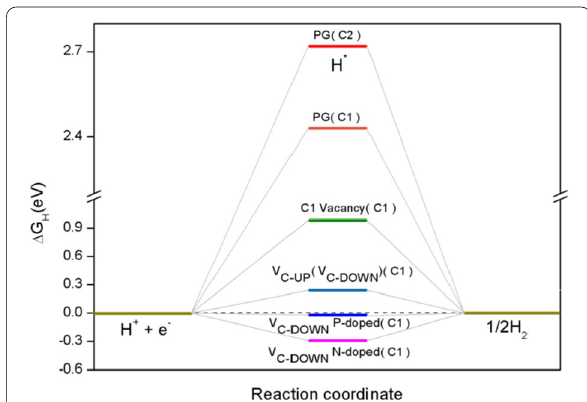
Fig. 8 Gibbs free energy versus reaction coordinate of the HER for PG, where C1 and C2 inside the brackets are active sites for hydrogen adsorption